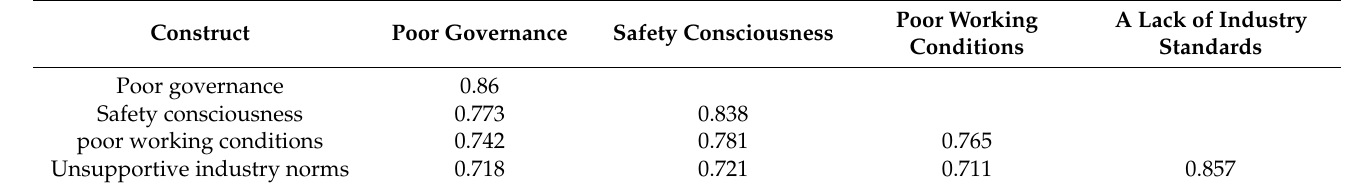
Table 4. Correlation of latent variables and discriminant validity (Fornell-Larcker).